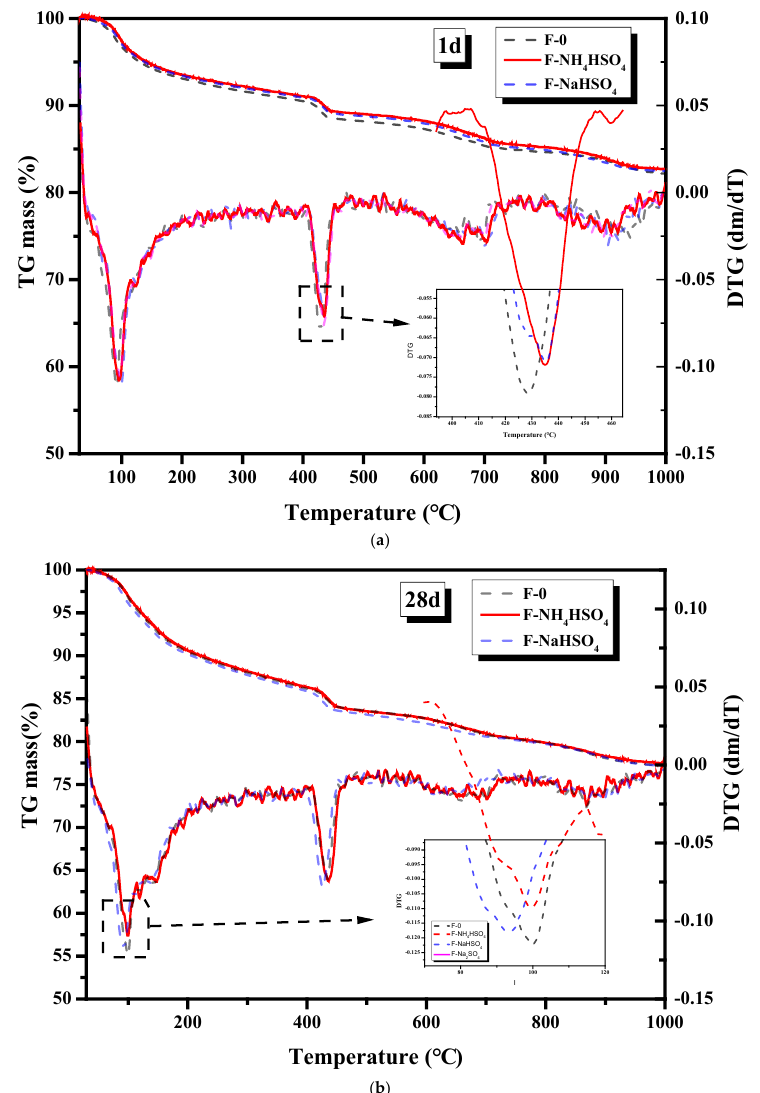
Figure 7. TGA spectra of the hydration products of the fly ash cement paste after ( a ) 1 day and ( b ) 28 days.